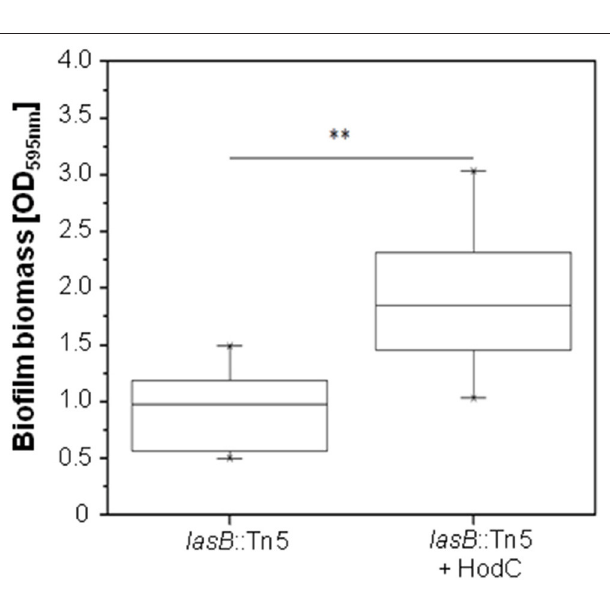
FIGURE 3 | Effect of HodC on pre-grown biofilms of P. aeruginosa PA14 lasB ::Tn. Overnight cultures (in LB) were diluted (1:100) in LB in 96-well microtiter plates, and incubated for 24 h at 37 ◦ C. After removal of planktonic cells and a washing step with LB, the biofilm was covered with fresh LB without or with HodC (70 U/ml) and incubated for another 24 h at 37 ◦ C. Biofilm cells were stained with 0.1% (w/v) crystal violet and quantified by measuring OD 595nm . Experiments were done in triplicates with 6 individual repeats per measurement ( n = 18). Statistical analyses were performed with the Mann-Whitney U -test. ** p ≤ 0.01. The highest and lowest outliers are indicated by